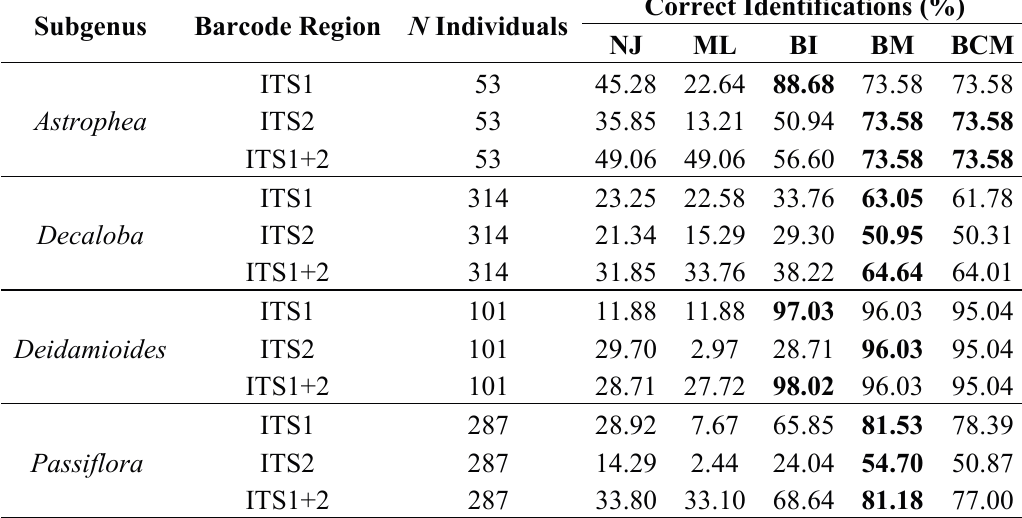
Table 3. Comparison of tree-based (NJ, ML, and BI) and similarity (BM and BCM) methods performance for different ITS datasets and subgenera. The highest values of percentage of correct individuals’ identification for each subgenus and barcode region are shown in